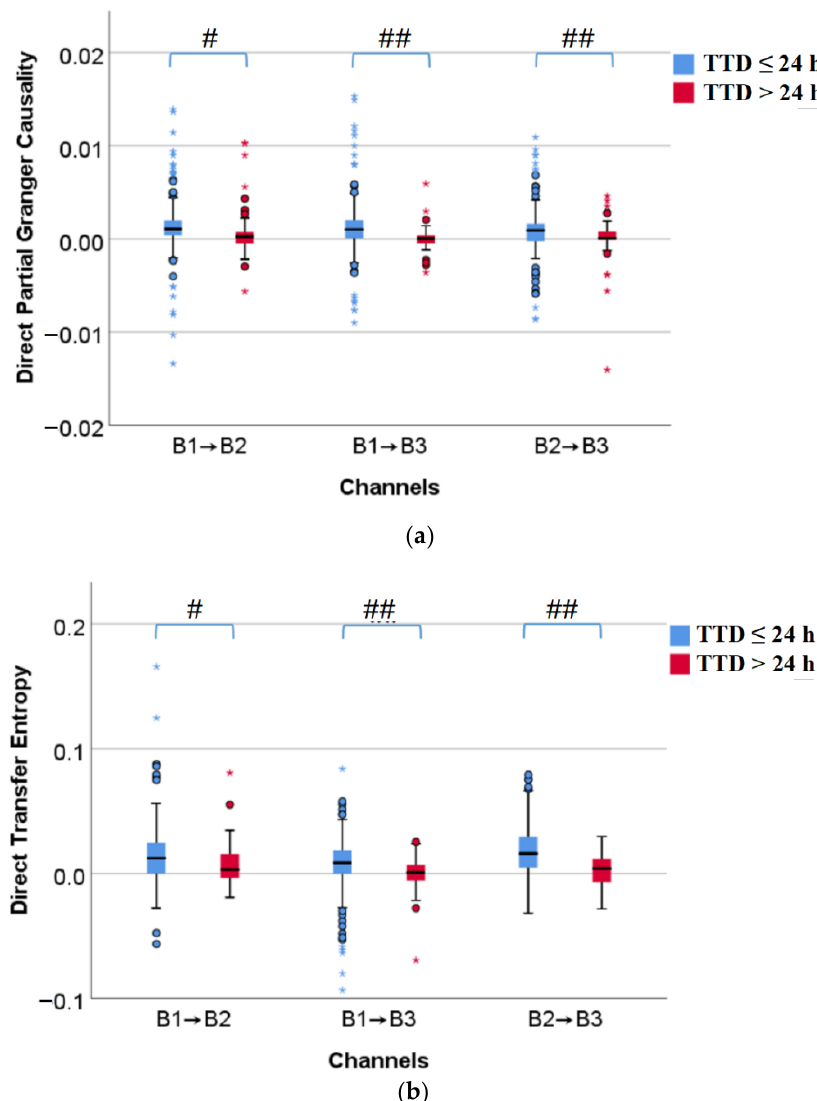
Figure 6. Comparison of information flow between TTD ≤ 24 h and TTD > 24 h. #: p < 0.05, ##: p < 0.01, ○ : the moderate outlier, *: the extreme outlier. ( a ) Direct partial Granger causality; ( b ) Direct transfer entropy.